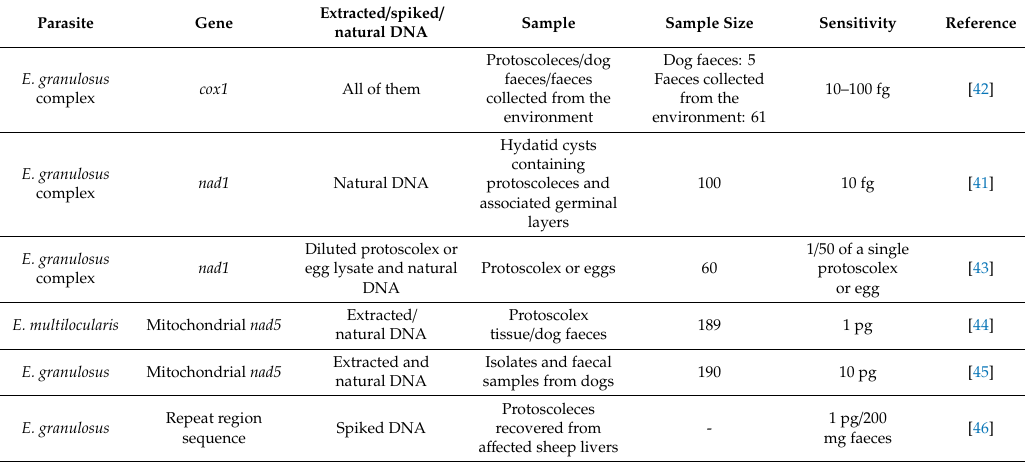
Table 3. Publications found in the US National Library of Medicine National Institutes of Health (NCBI-PubMed) reporting the standardisation of the LAMP technique as a useful tool for diagnosing echinococcosis in the definitive